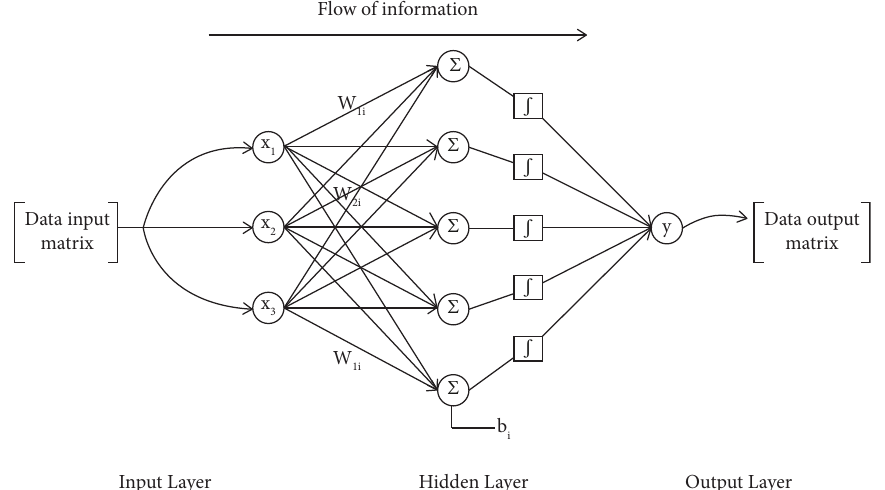
Figure 1: Schematic diagram of FFNNM with backpropagation